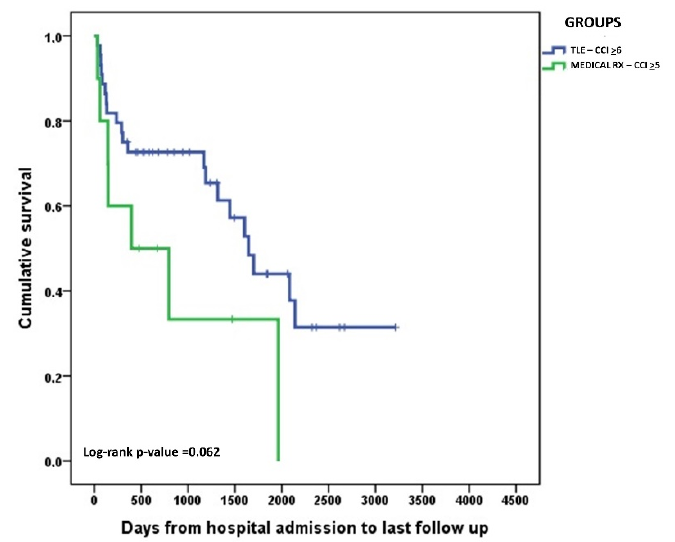
Figure 3. Kaplan–Meier curves comparing long-term survival probability of the two subgroups of patients with a CCI higher that the group median managed with medical therapy only vs. TLE.